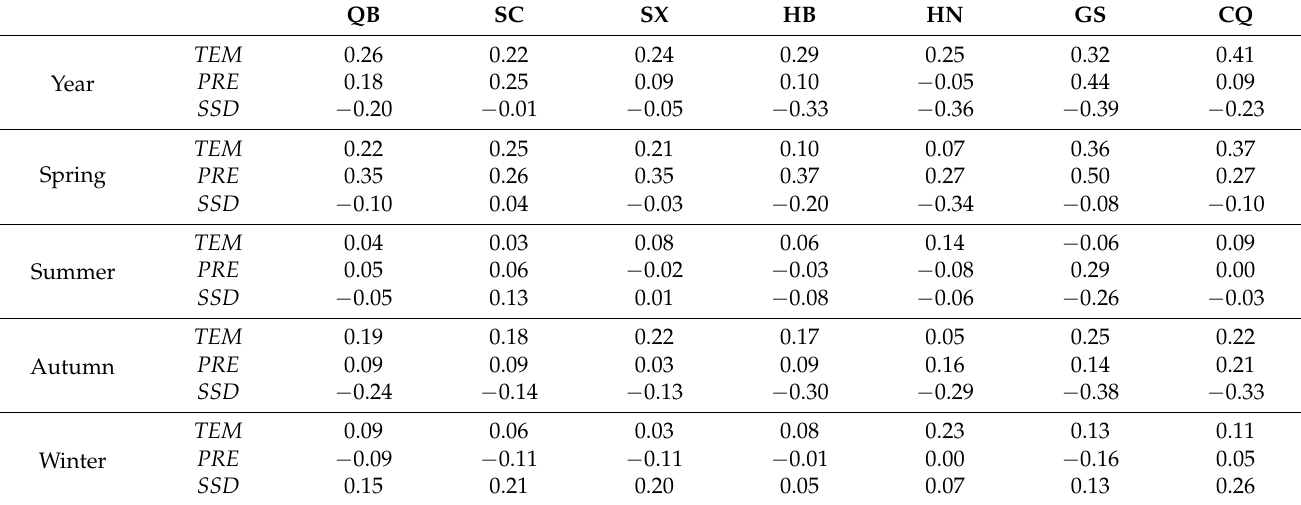
Table 9. Correlation coefficient between FVC and climatic factors in the